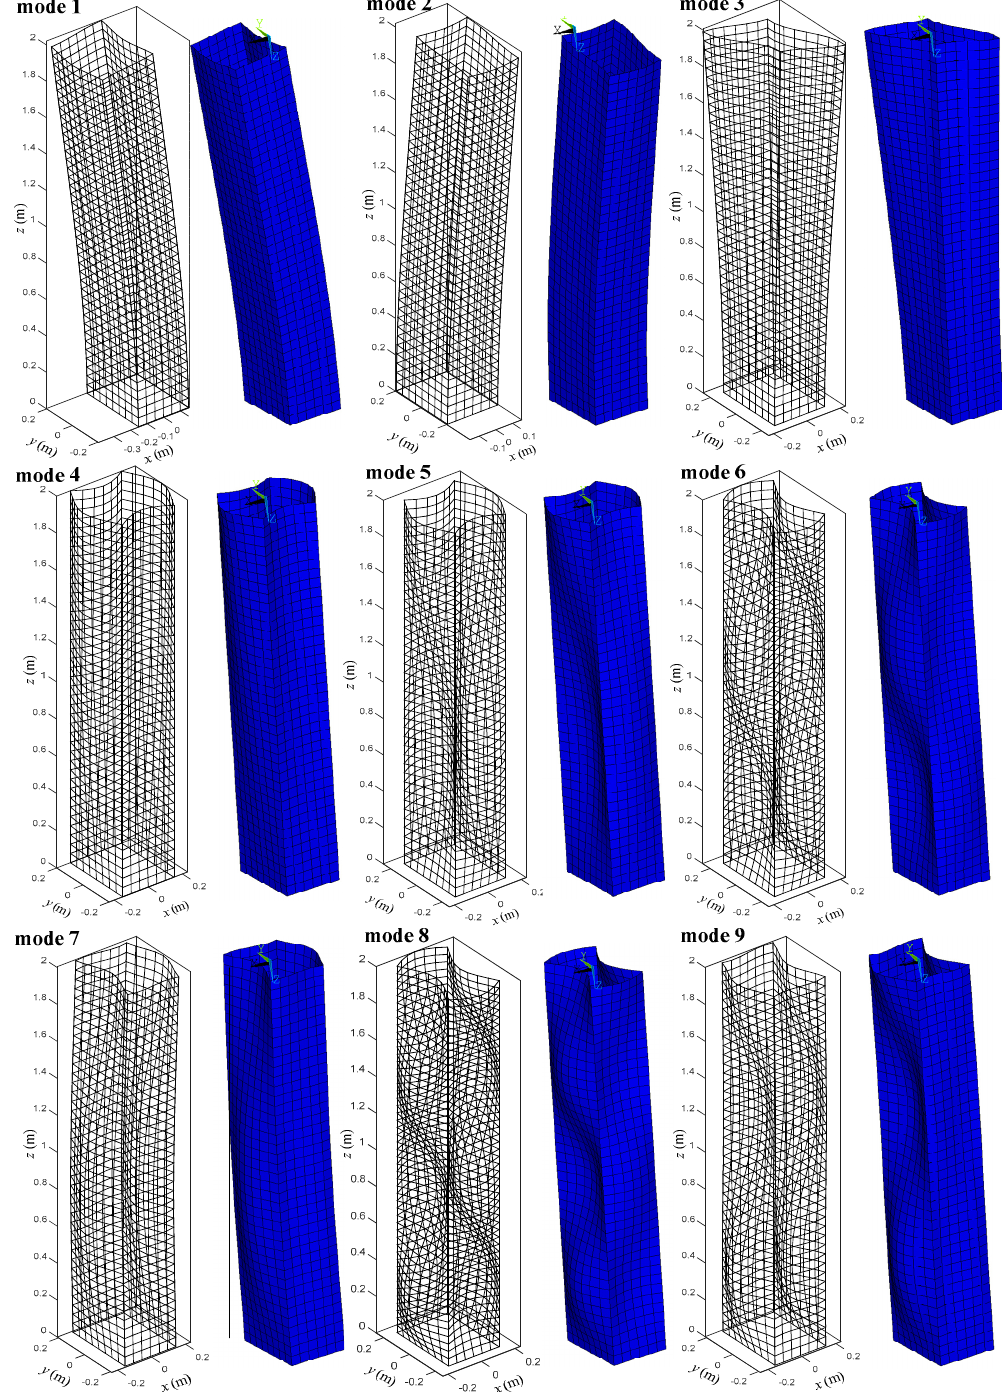
Figure 13. Comparison of modal shapes of the cantilevered thin-walled structure between ANSYS shell model (the right ) and present model (the l eft